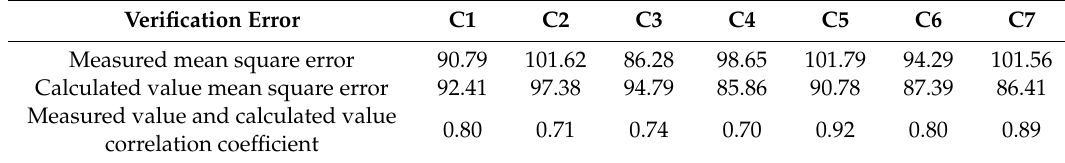
Table 4. Tidal current direction verification